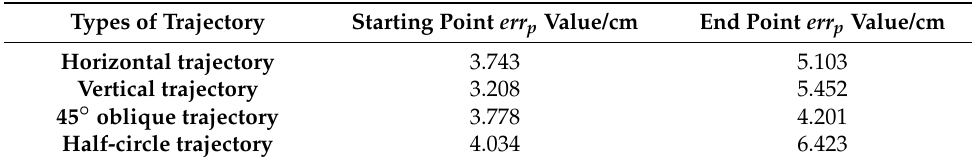
Table 1. Upper limb position solution error